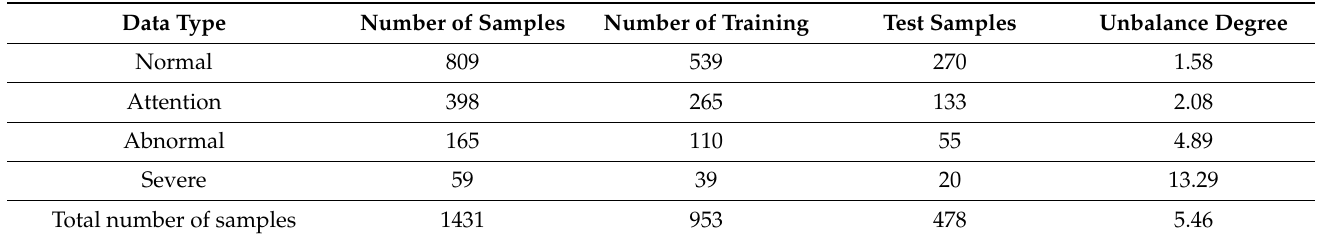
Table 2. Data distribution.